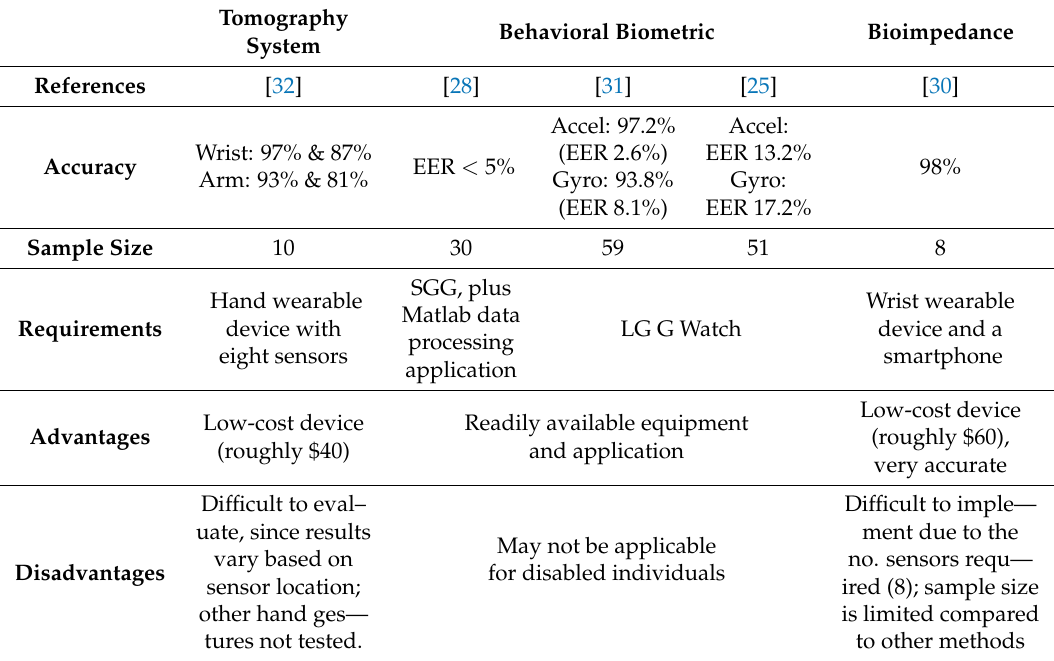
Table 5. Bracelet (Hand) Wearable Device Evaluation by technique.